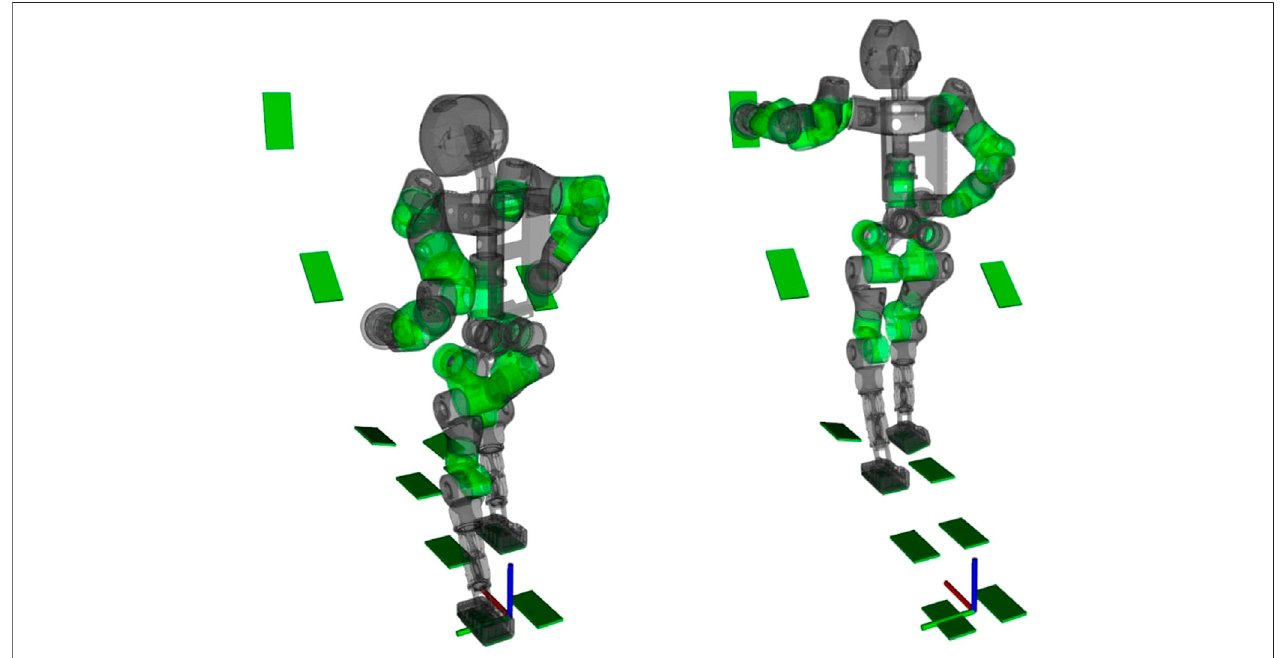
FIGURE 5 | Captures of COMAN+ moving on a sequence of prede fi ned stances while the NSPG generates feasible con fi gurations.